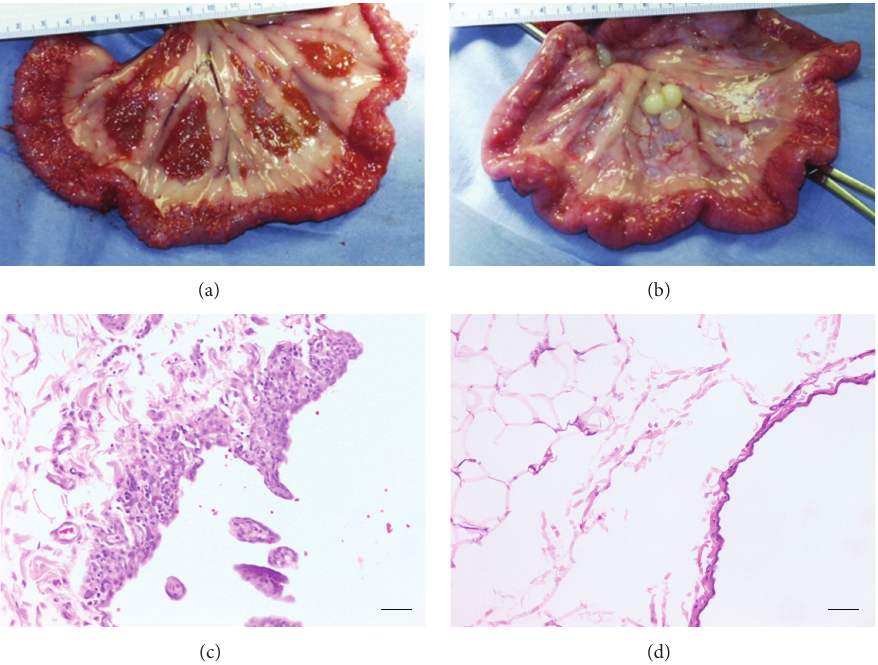
Figure 4: Gross and microscopic images of the mesentery from two representative study animals. Small intestine and mesentery from a control (nonpravastatin) treated animal (ORL-0; (a)) and pravastatin-treated animal (VPL-0, (b)). Microscopic images of the same tissues from these animals are shown in (c) (ORL-0) and (d) (VPL-0). Original magnification of (c) and (d) was 200x. Scale bar is 200 𝜇